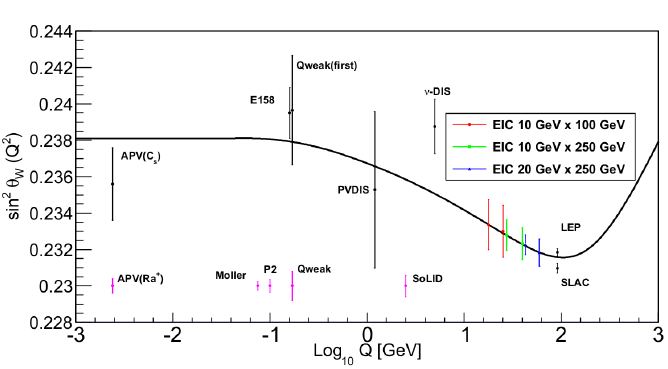
Figure 4: By measuring partiy-violating DIS at the EIC, new coverage and precision can be introduced in determinations of sin 2 θ this assumes an integrated luminosity of 400 fb − 1